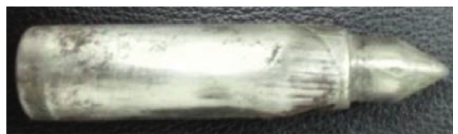
Figure 1: Projectile used in test.